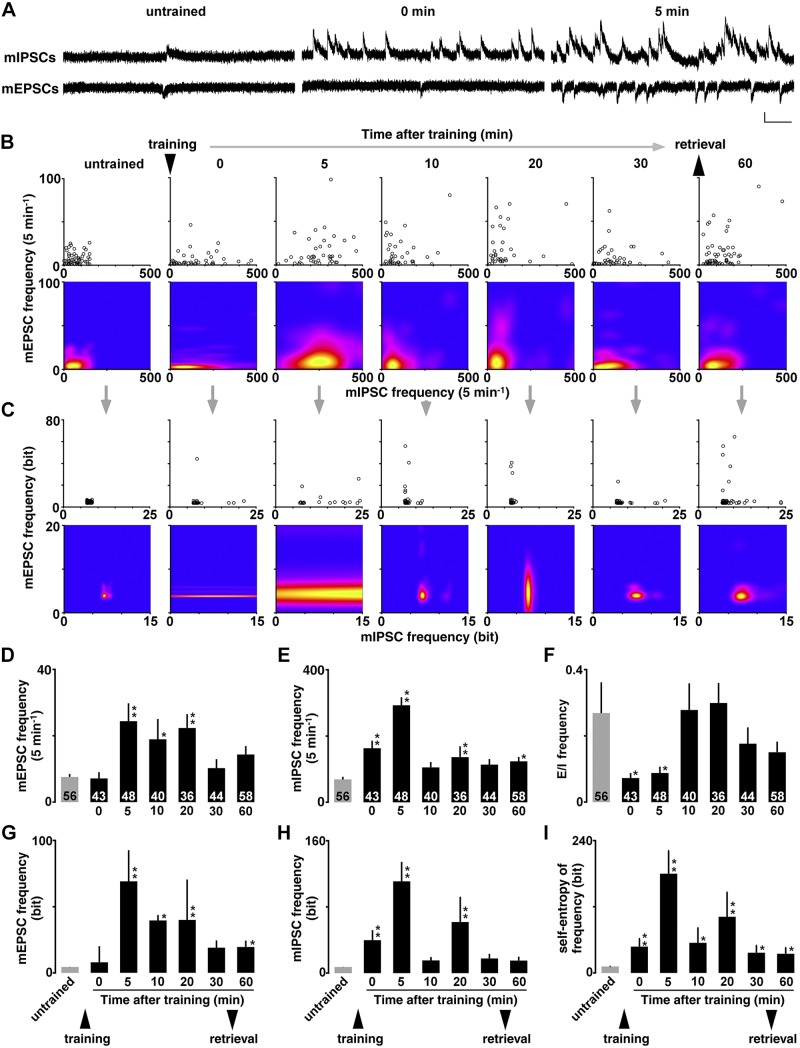
Temporal dynamics of the learning-induced diversity of mEPSC and mIPSC frequencies and entropy analysis. A) Representative traces of mEPSCs and mIPSCs. Vertical bar = 20 pA; horizontal bar = 50 ms. B) Plots of the means mEPSC and mIPSC frequency in each neuron (upper) and the visualized density by kernel analysis (lower). C) By calculating appearance probability of each dot, we plotted self-entropy (bit) of individual neurons (upper) and visualized the density by kernel analysis in untrained and trained rats (lower). D, E) Mean frequency of mEPSCs (D) or mIPSCs (E) in all recorded neurons in untrained and trained rats. IA training increased mEPSC frequency within 5 min, whereas it increased mIPSC frequency within 1 min after the training (0 min). F) E/I balance of the mEPSC and mIPSC frequency transiently decreased from 0 to 5 min after the training. G, H) The training also increased the self-entropy (bit) of excitatory (G) and inhibitory (H) synapses in CA1 neurons. I) Combined self-entropy (bit) of the mEPSC and mIPSC frequencies in untrained and trained rats. The number of cells in each group is shown at the bottom of each bar. Error bars indicate + sem. *P < 0.05, **P < 0.01 vs. untrained. ▼ or ▲ indicate the timing of training or retrieval tests.